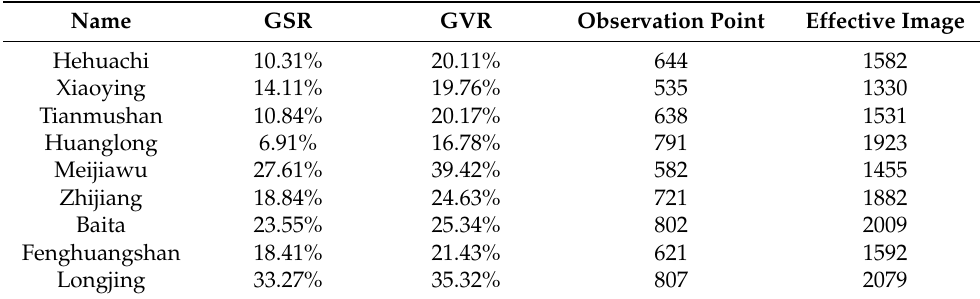
Table 4. The GSR and GVR of each